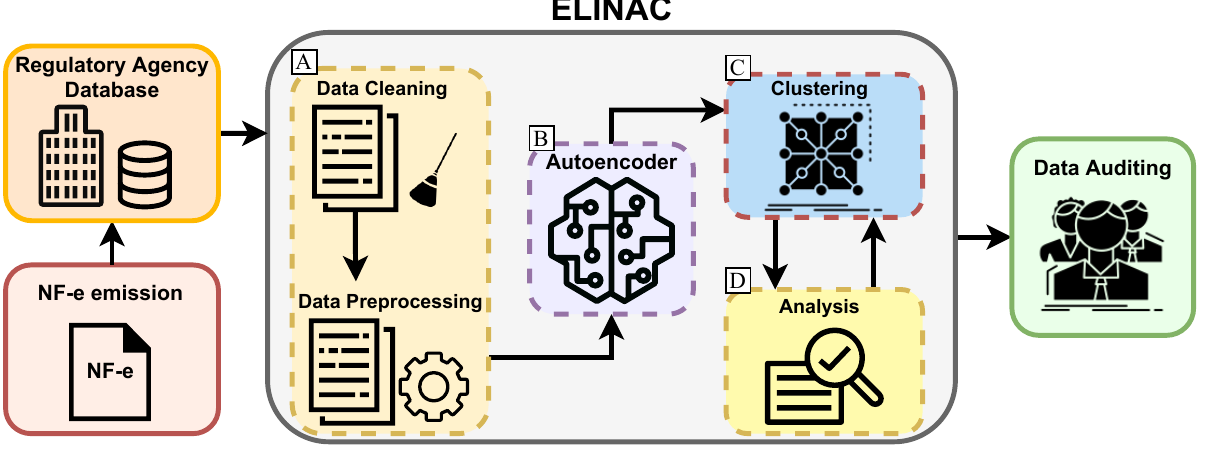
Figure 1. ELINAC operating